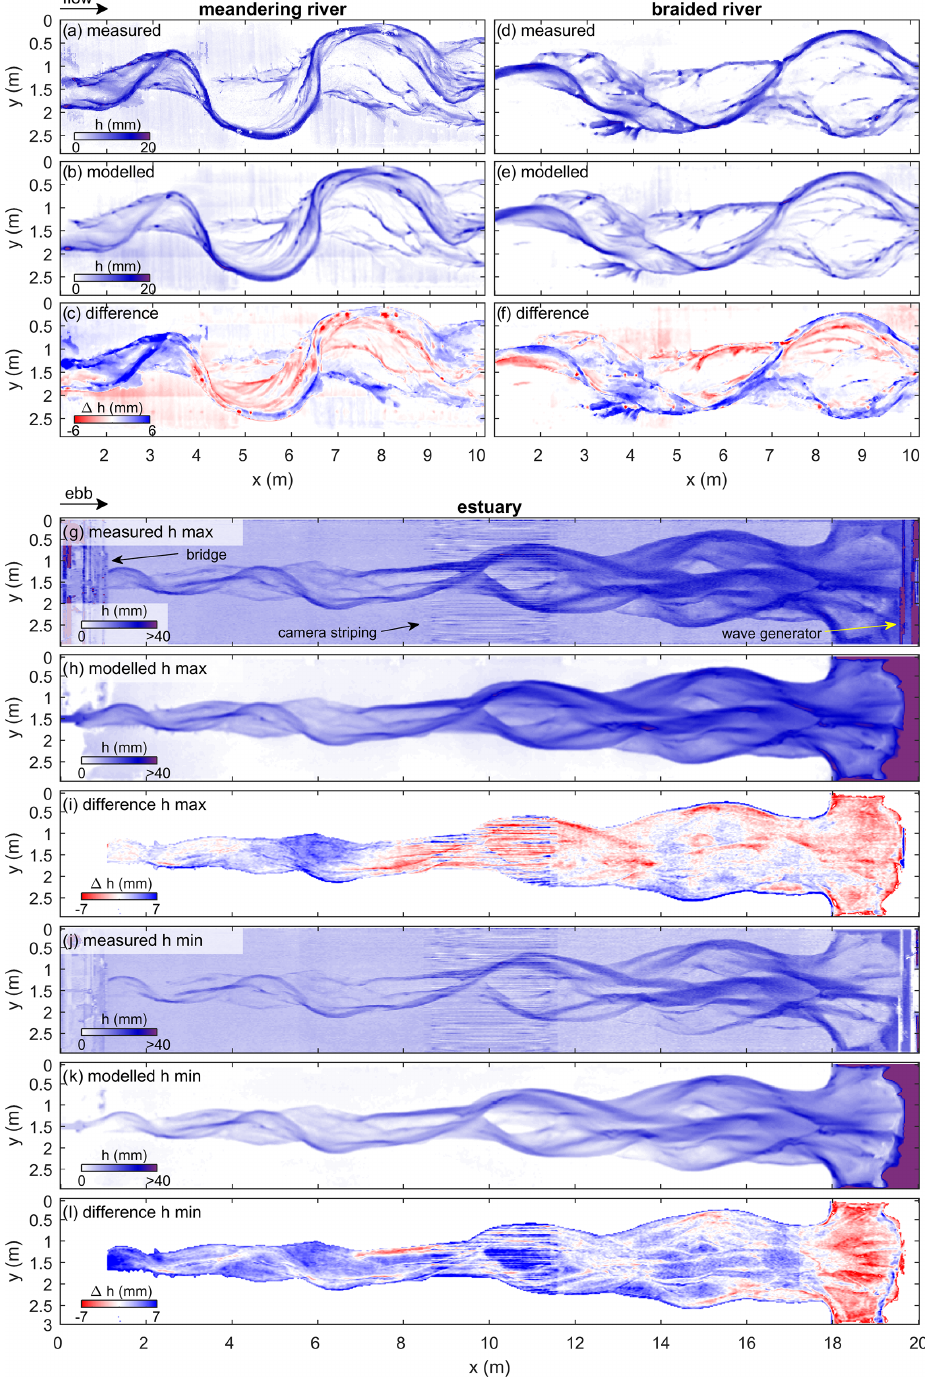
Figure 4. Measured and modelled water depth (a–c) for the meandering and (d–f) braided rivers by Van Dijk et al. (2013a) and (g–l) for the estuary by Leuven et al. (2018). In the case of the estuary, panels (g–i) show the maximum water depth during a tidal cycle, and panels (j–k) show the minimum water depth during a tidal cycle. Maps of difference are determined by subtraction of modelled from measured water